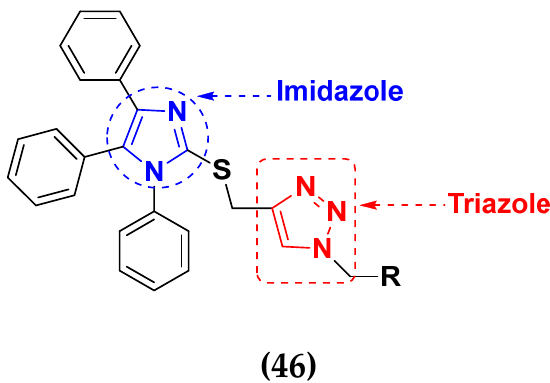
Figure 52. Structure of imidazole based triazole hybrid derivatives ( 46 ).